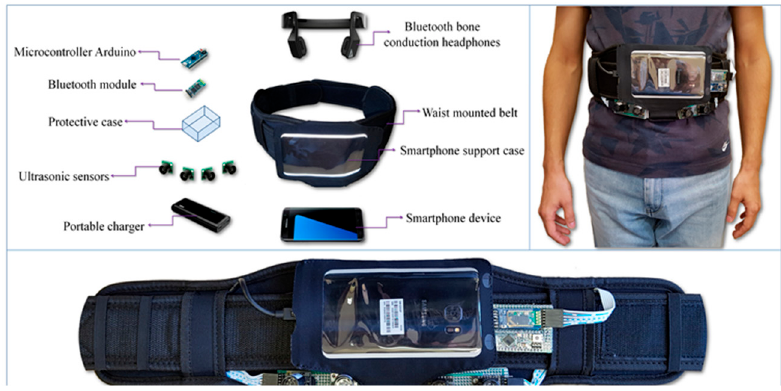
Figure 38. The prototype of the proposed system [60].